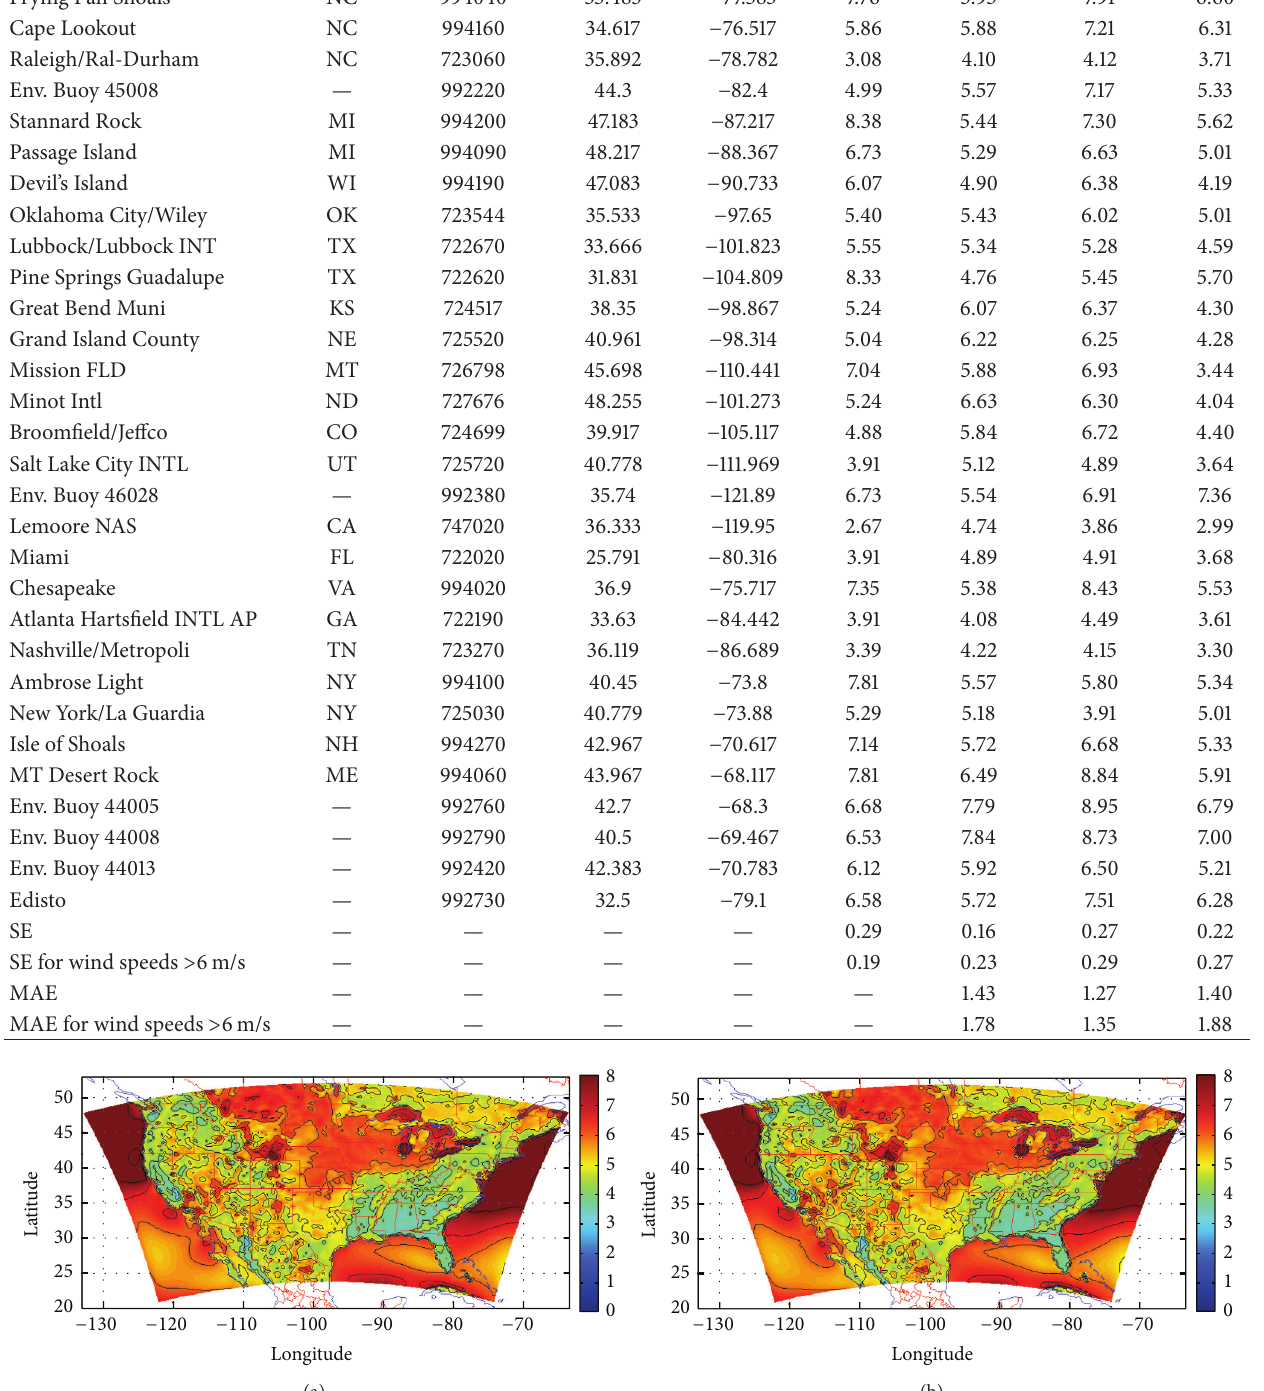
Figure6:Dynamicaldownscaledaverageannualwindspeed(m s −1